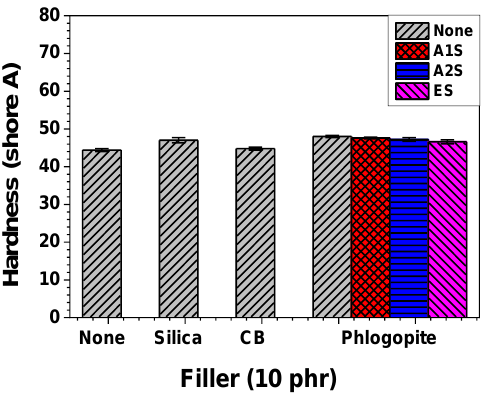
Figure 4. Shore A hardness of the NR/EPDM blend and composites with different fillers and functionalization types (amino- and epoxide-functionalized) for phlogopite.